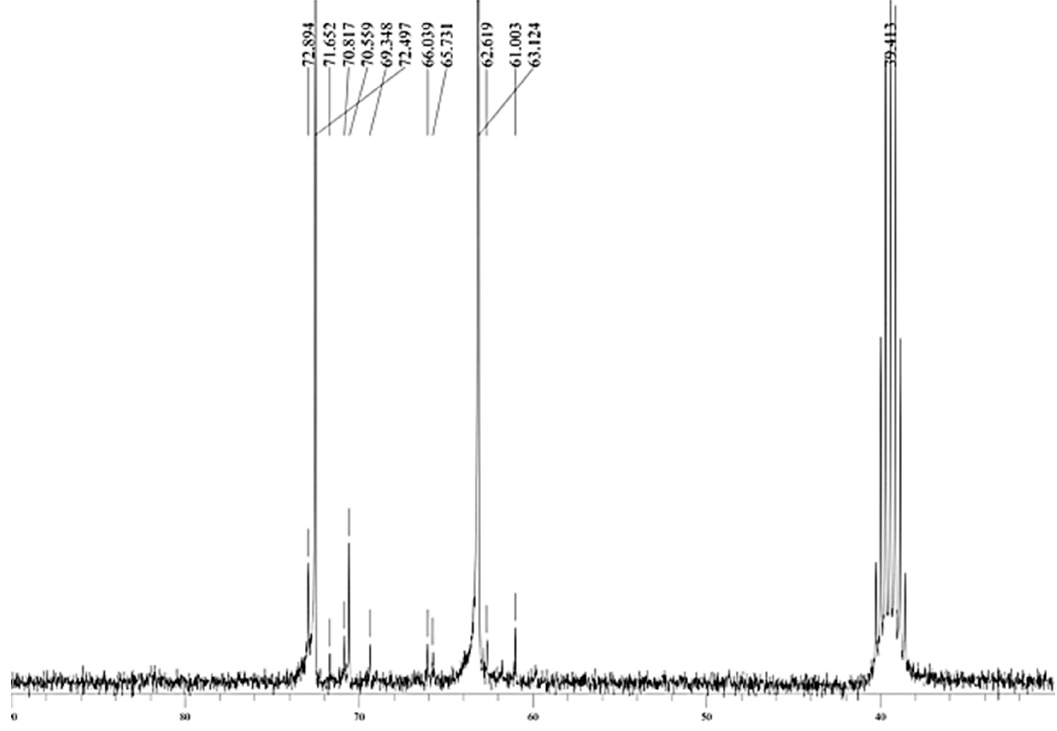
Figure 13. Spectrum 13 C-NMR (75 MHz DMSO-d6) of mixture of reaction at 24 h in the range 30–90 ppm .